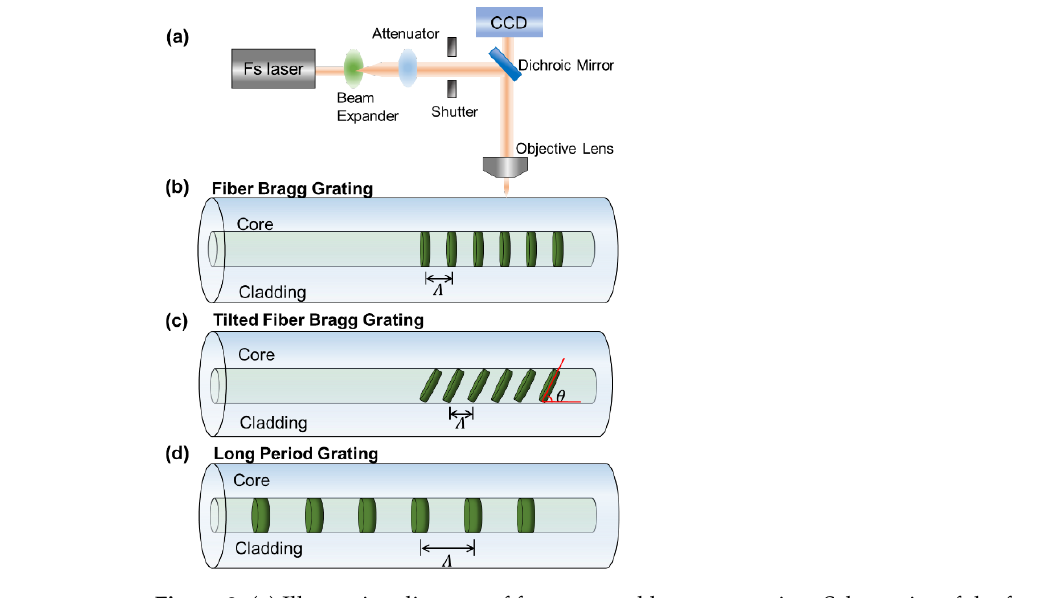
Figure 3. ( a ) Illustrative diagram of femtosecond laser processing. Schematics of the femtosecond − laser − induced grating and transmission principles: ( b ) FBG, ( c ) TFBG, and ( d ) LPG.